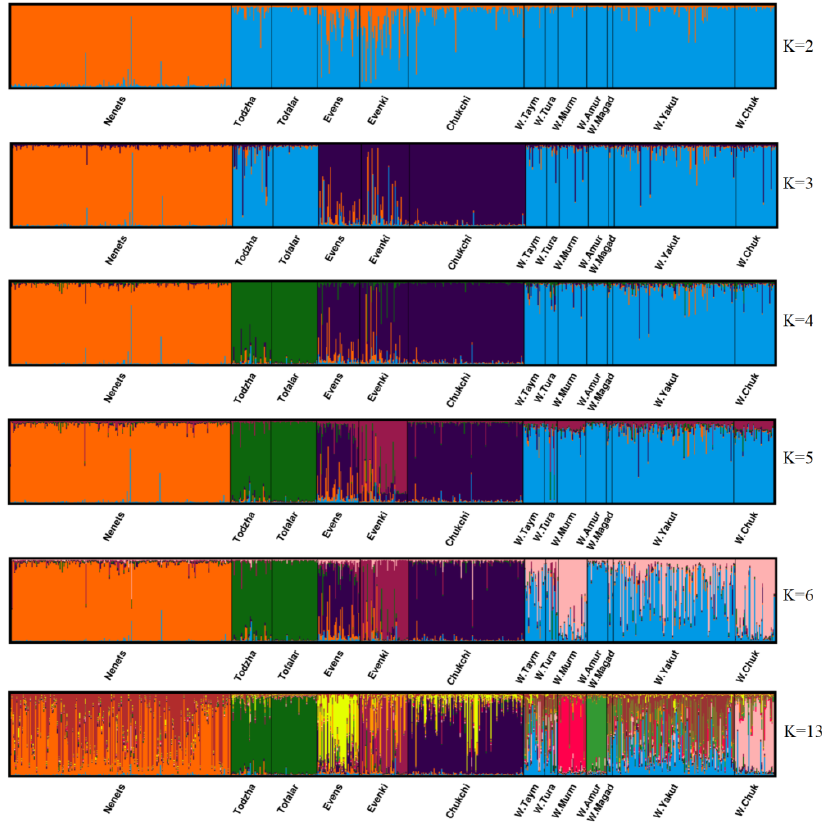
Figure 3. Results of STRUCTURE analysis based on microsatellite genotypes. Colour indicates the proportion of membership of each animal to K assumed clusters.